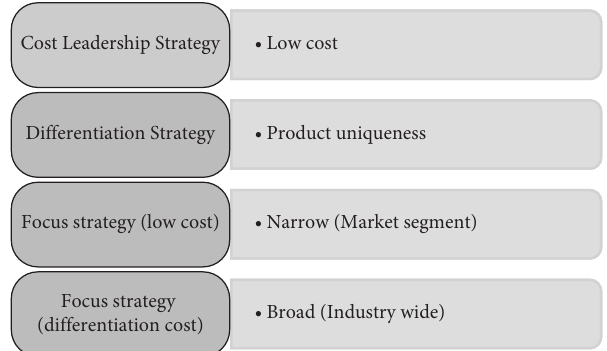
Figure 1: Porter’s generic three strategies’